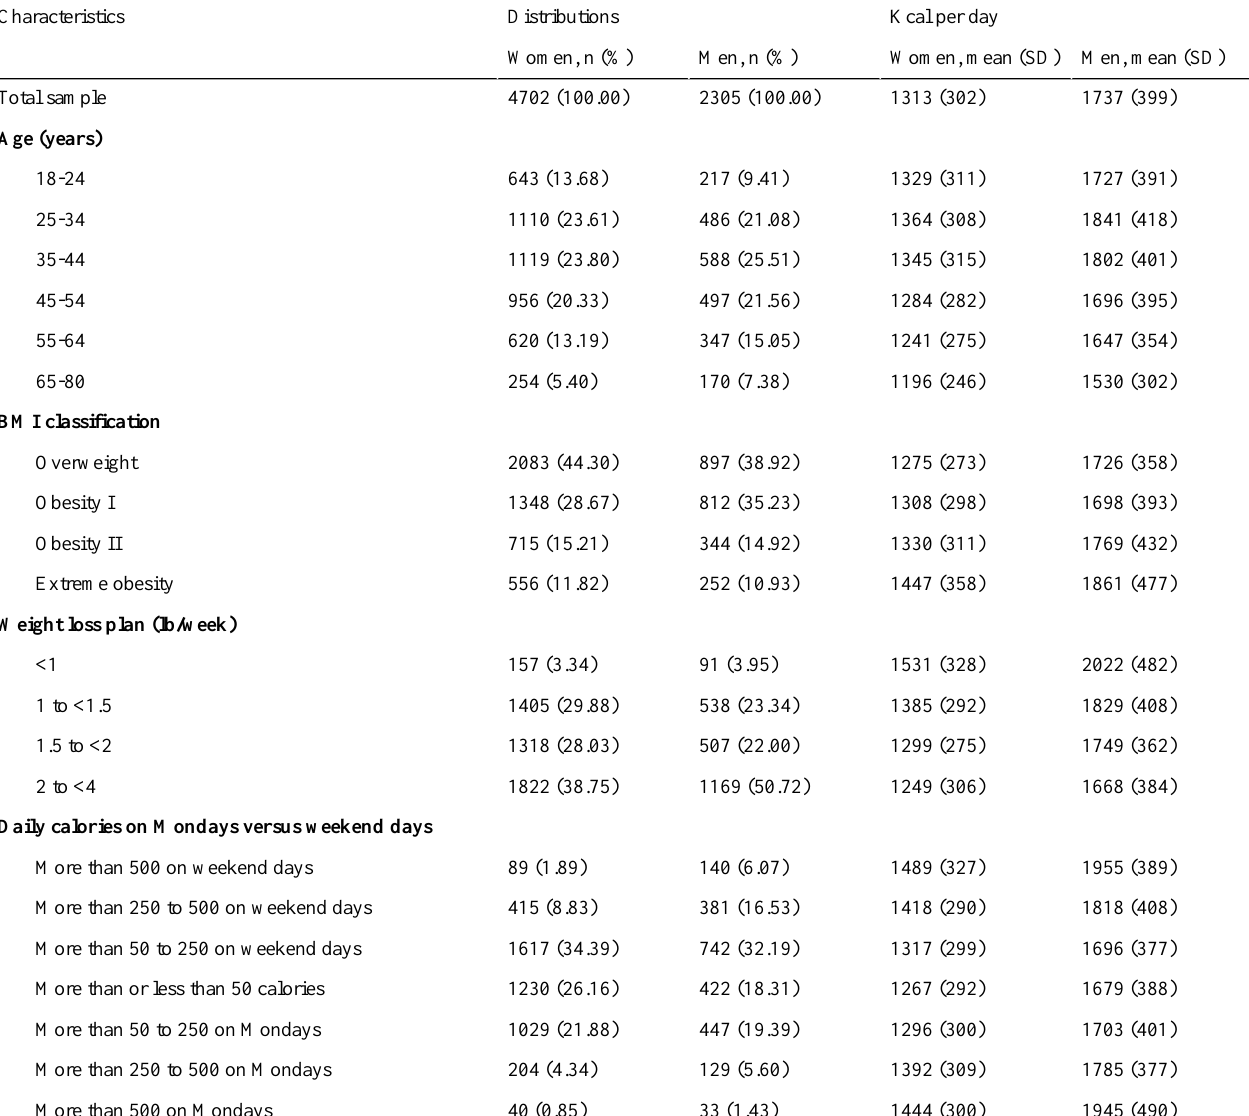
Table 1. Individual characteristics and daily caloric intake for women and men using the Lose It! mobile phone app (N=7007). BMI: body mass index.